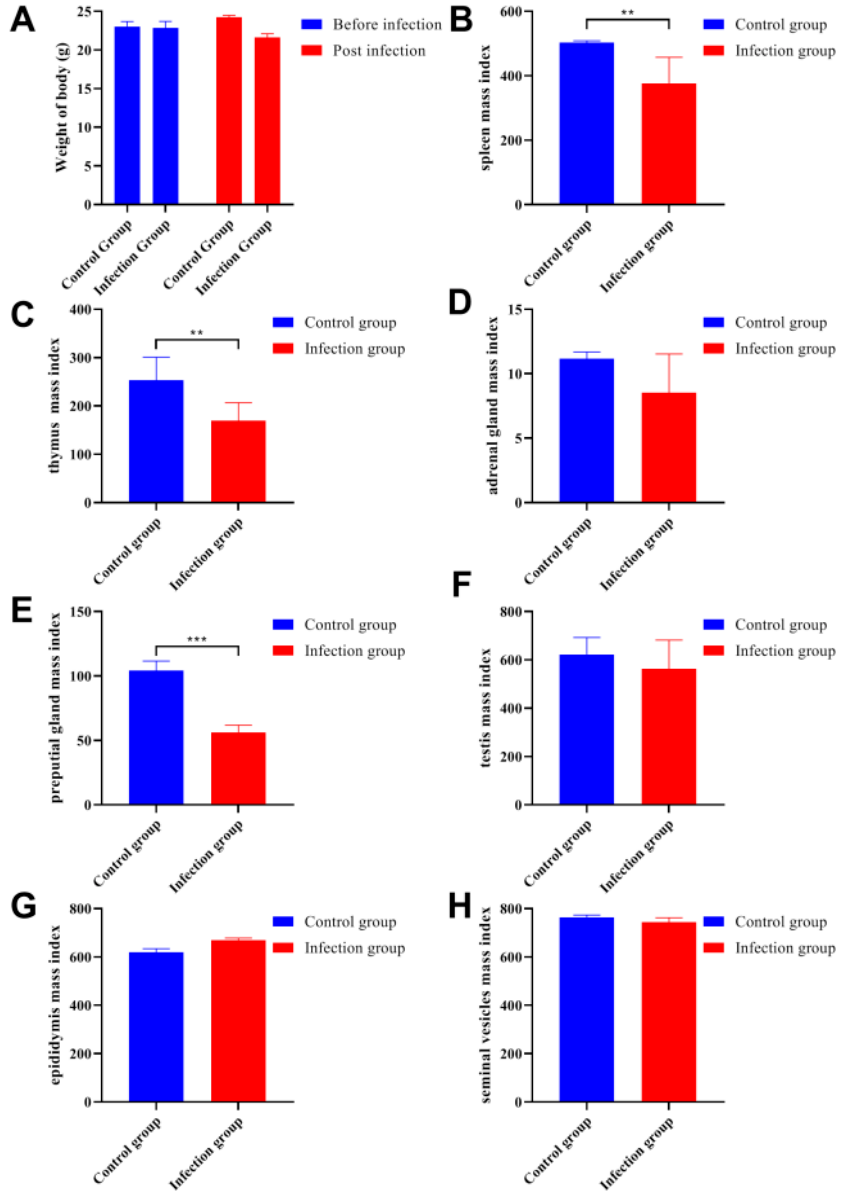
Figure 2. C. parvum infection decreased the physiological indexes. ( A ) The comparison of body weight between the infection group and control group before and after parasitic infection. ( B – H ) The changes in mass indexes for different organs between the two groups are presented before and after parasitic infection,. The mass indexes of the spleen, thymus, and preputial gland were reduced after parasitic infection. All data are presented as means ± standard deviation. Two-way ANOVA was used for significance analysis, and all statistical analyses were performed with GraphPad Prism 8. *** p <0.001; ** p <0.01.